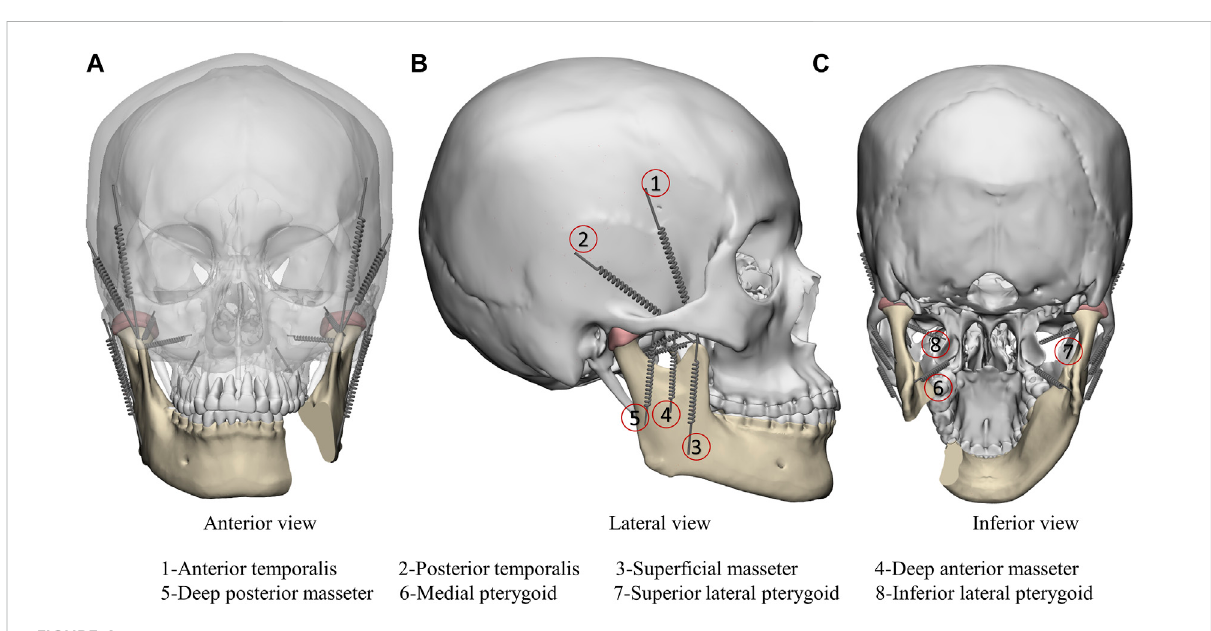
FIGURE 4 Finiteelementmodelboundaryconditionsincludinganteriorview (A) ,lateralview (B) andinferiorview (C) .Masticatorymusclewassimulatedas spring element: 1-Anterior temporalis; 2-Posterior temporalis; 3-Super fi cial masseter; 4-Deep anterior masseter; 5-Deep posterior masseter; 6- Medial pterygoid; 7-Superior lateral pterygoid; 8-Inferior lateral